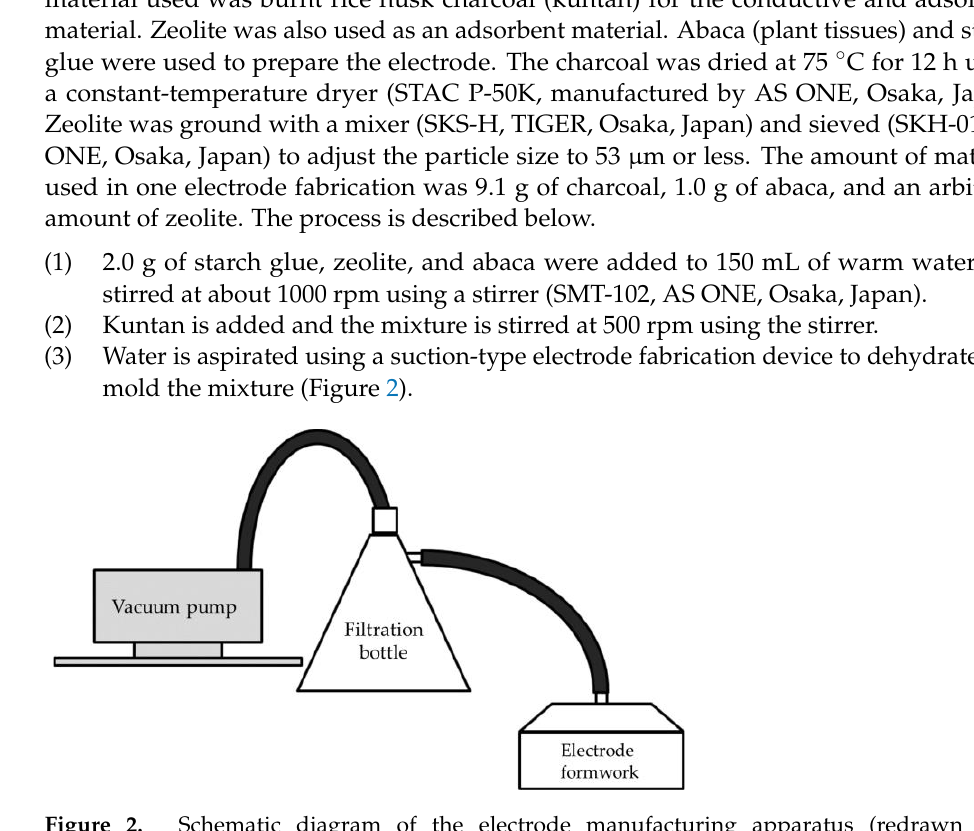
Figure 2. Schematic diagram of the electrode manufacturing apparatus (redrawn from Hatakeyama et al.,